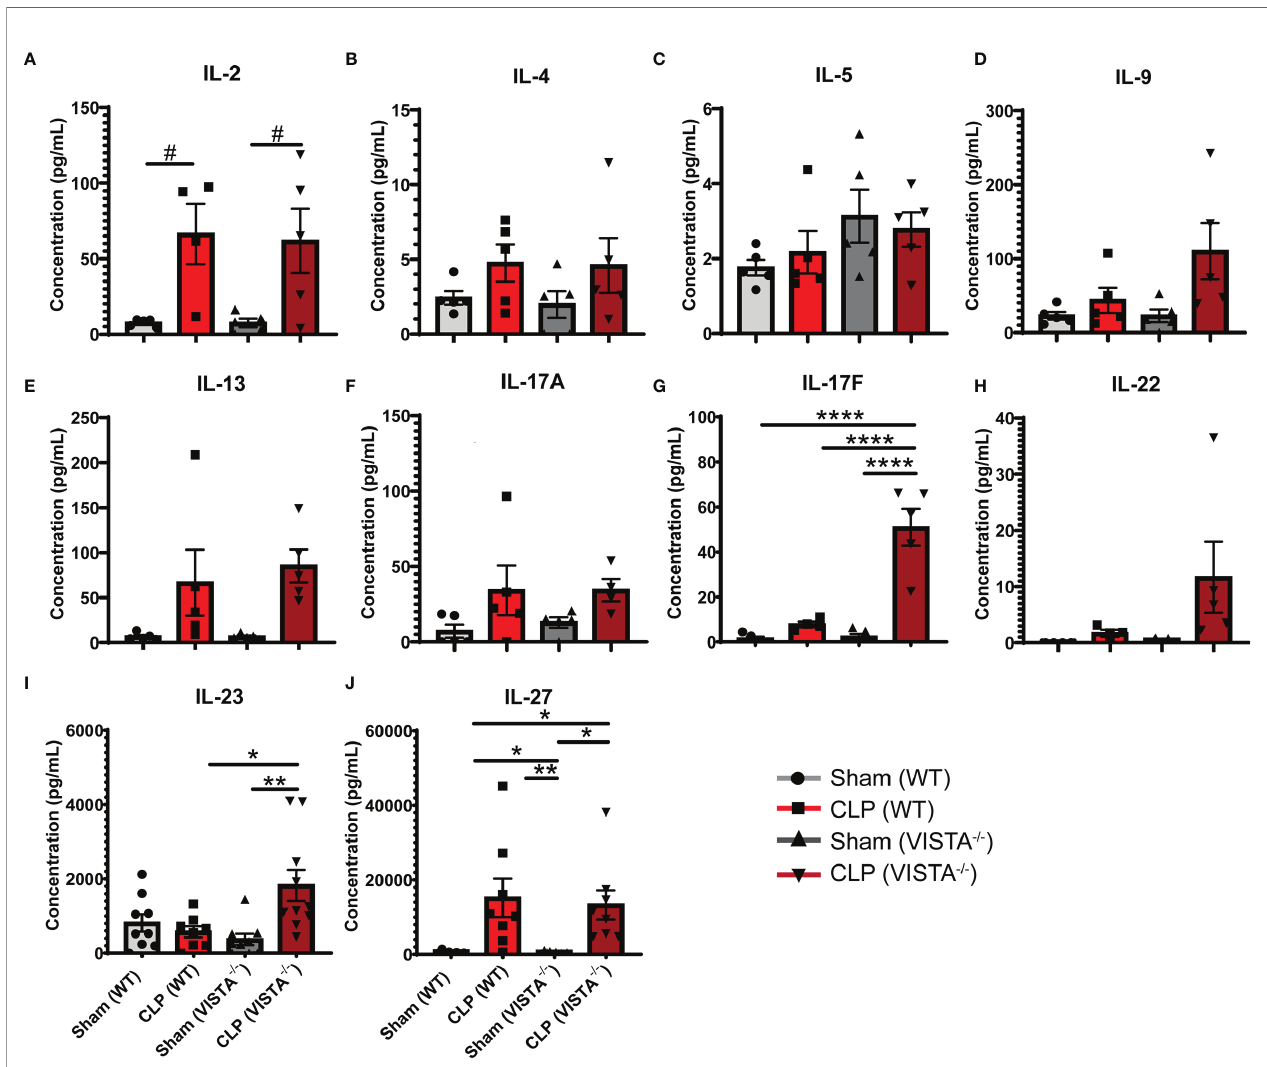
FIGURE 7 | VISTA -/- mice have signi fi cantly higher levels of several Th17 cytokines following septic challenge. (A – J) Plasma cytokine concentration of wild-type and VISTA -/- mice. Summary graphs show mean ± SEM [WT-sham: n = 5 , WT-CLP: n = 5 , VISTA -/- sham: n = 5 , VISTA -/- -CLP: n=5 ]; signi fi cance # p = 0.05; *p < 0.05; **p < 0.01; ****p <